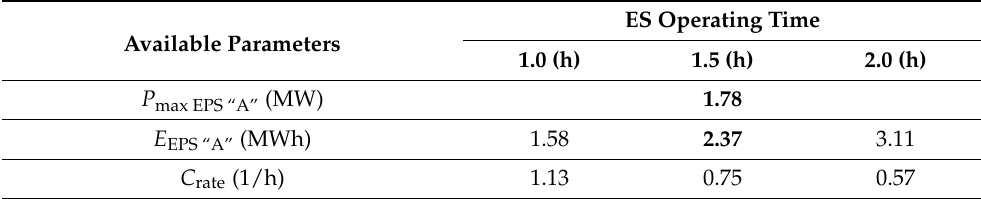
Table 6. Power P ES and energy E ES of energy storage.